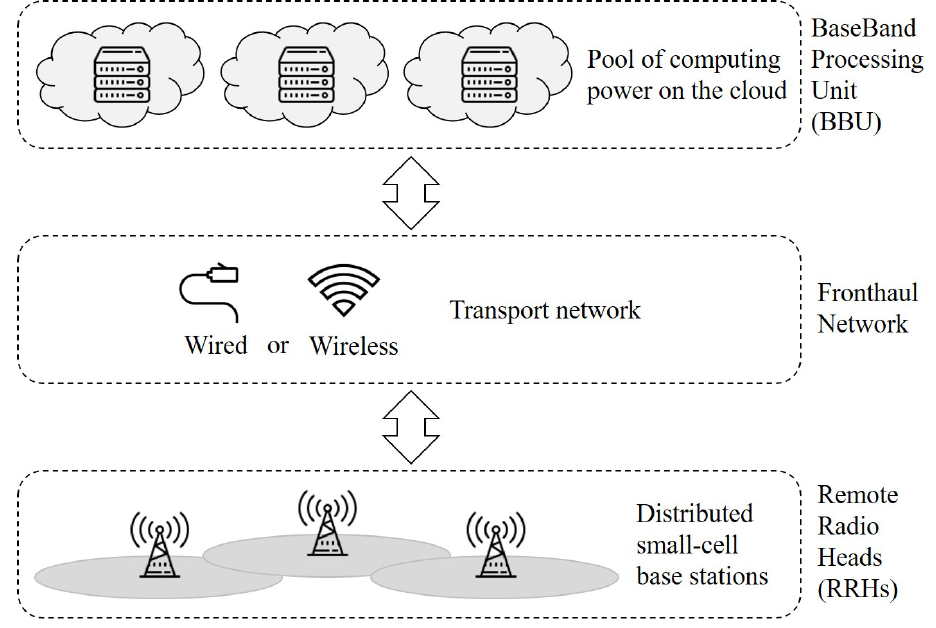
Figure 1. The three-layer architecture of